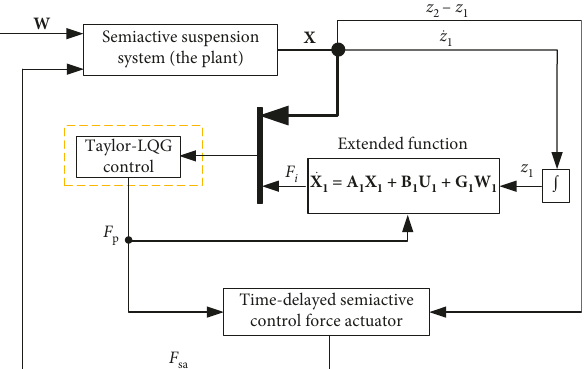
Figure 2: Block diagram of the TLQG